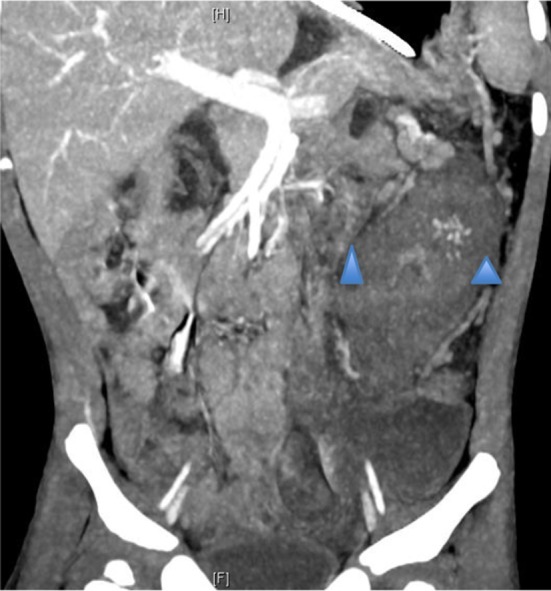
Abdominal CT with contrast. Marked bowel wall thickening of left colon (see blue arrows) extending from the distal transverse to the descending colon. There is an area of spared bowel in the mid descending colon. The thickened bowel is homogenous in attenuation, with relative hyper enhancement of the mucosa. There is abrupt transition between normal and abnormal bowel (shouldering). There is involvement of the serosa with multiple serosal nodules and infiltration of the pericolonic fat.